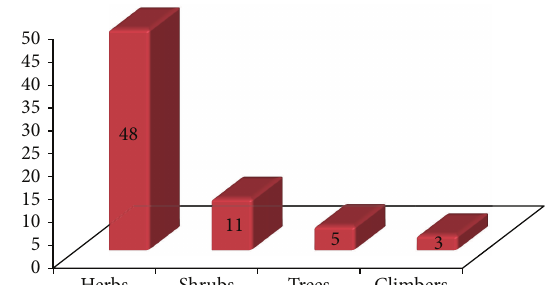
Figure 4: Mode of utilization of plants.